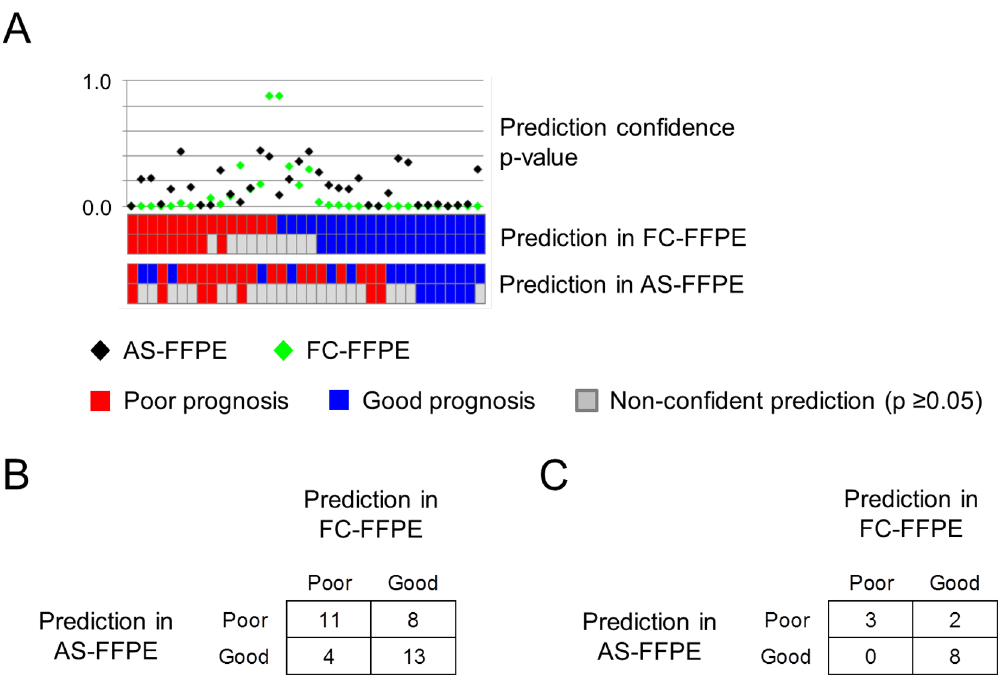
Figure 6. Comparison of transcriptome-based prediction of cirrhosis prognosis between FC-FFPE and AS-FFPE RNA extracted from the same tissue blocks (n=36). (A) Cirrhosis prognosis prediction results for each sample. (B) Contingency table of prediction results comparing FC-FFPE and AS-FFPE. (C) Contingency table of prediction results in 13 samples with statistically more confident prediction (prediction confidence p- value , 0.05). AS: archived section, FFPE: formalin-fixed paraffin-embedded, FC: freshly cut.